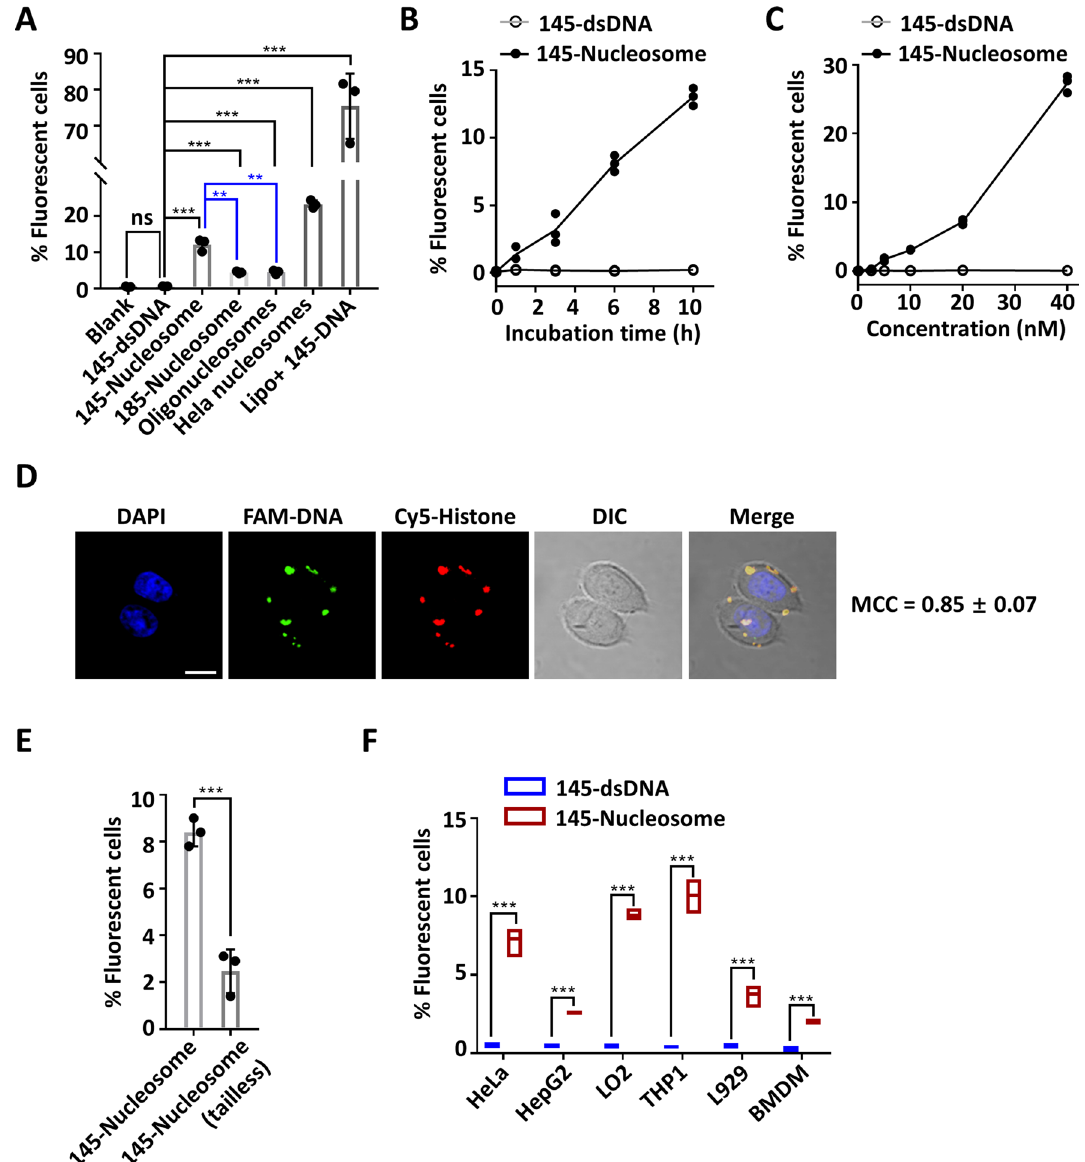
Figure 2. Cellular entry of nucleosomes. ( A ) Flow cytometry analysis of the uptake of free DNA and nucleosomes by HeLa cells. HeLa cells were incubated with 145-dsDNA or nucleosomes (20 nM) for 10 h. ( B ) Flow cytometry analysis of the time-dependent uptake of 145-nucleosomes (20 nM) by HeLa cells. ( C ) Flow cytometry analysis of the concentration-dependent uptake of 145-nucleosomes (after 6 h incubation) by HeLa cells. ( D ) Representative images showing the cellular location of 145-nucleosomes in HeLa cells after incubation for 12 h. FAM was tagged on the 5 ′ end of one DNA strand, and Cy5 was conjugated to Histone H3. Scale bar, 20 μm. MCC (Manders’ colocalization coefficient) is the ratio of the FAM signal that overlaps with the Cy5 signal to the total signal of FAM. ( E ) Flow cytometry analysis of the uptake of tailless 145-nucleosomes (20 nM) by HeLa cells (after 6 h incubation). Tailless 145-nucleosomes contain tailless histone mutants, H4-del 1–20, H3-del 1–37, H2A-del 1–15 and H2B-del 1–31, instead of wild type histones. ( F ) Flow cytometry analysis of cellular uptake of 145-nucleosomes (20 nM) to different cell lines after 6 h incubation. For all graphs, error bars indicate the mean ± standard deviation of three independent experiments. Statistical significance was determined based on Student’s t -test (ns, p > 0.05; *0.05 > p > 0.01; **0.01 > p > 0.001; ***0.001 >